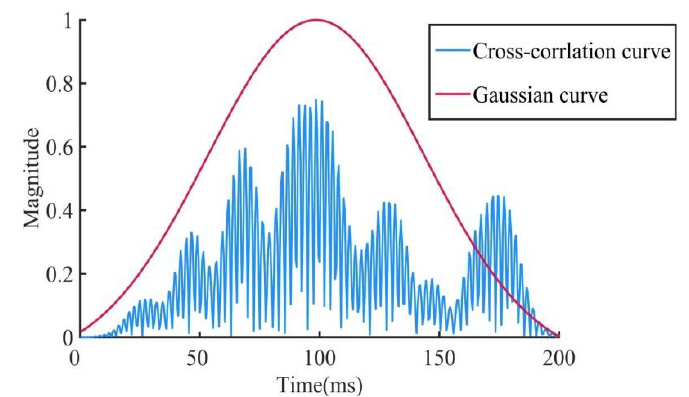
Figure 2. Cross-correlation curve.